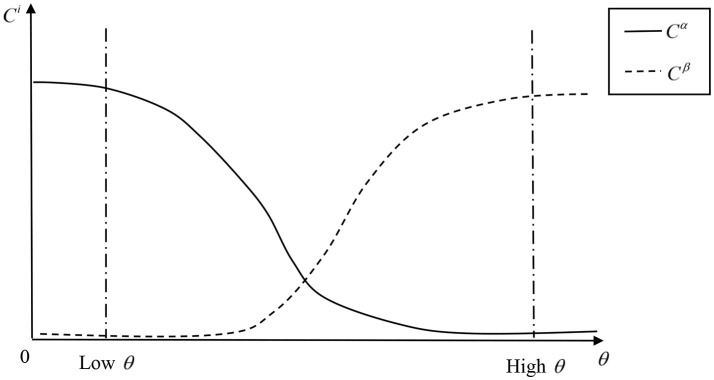
Truthful Contribution Schedules and the Level of GM Food Regulations.